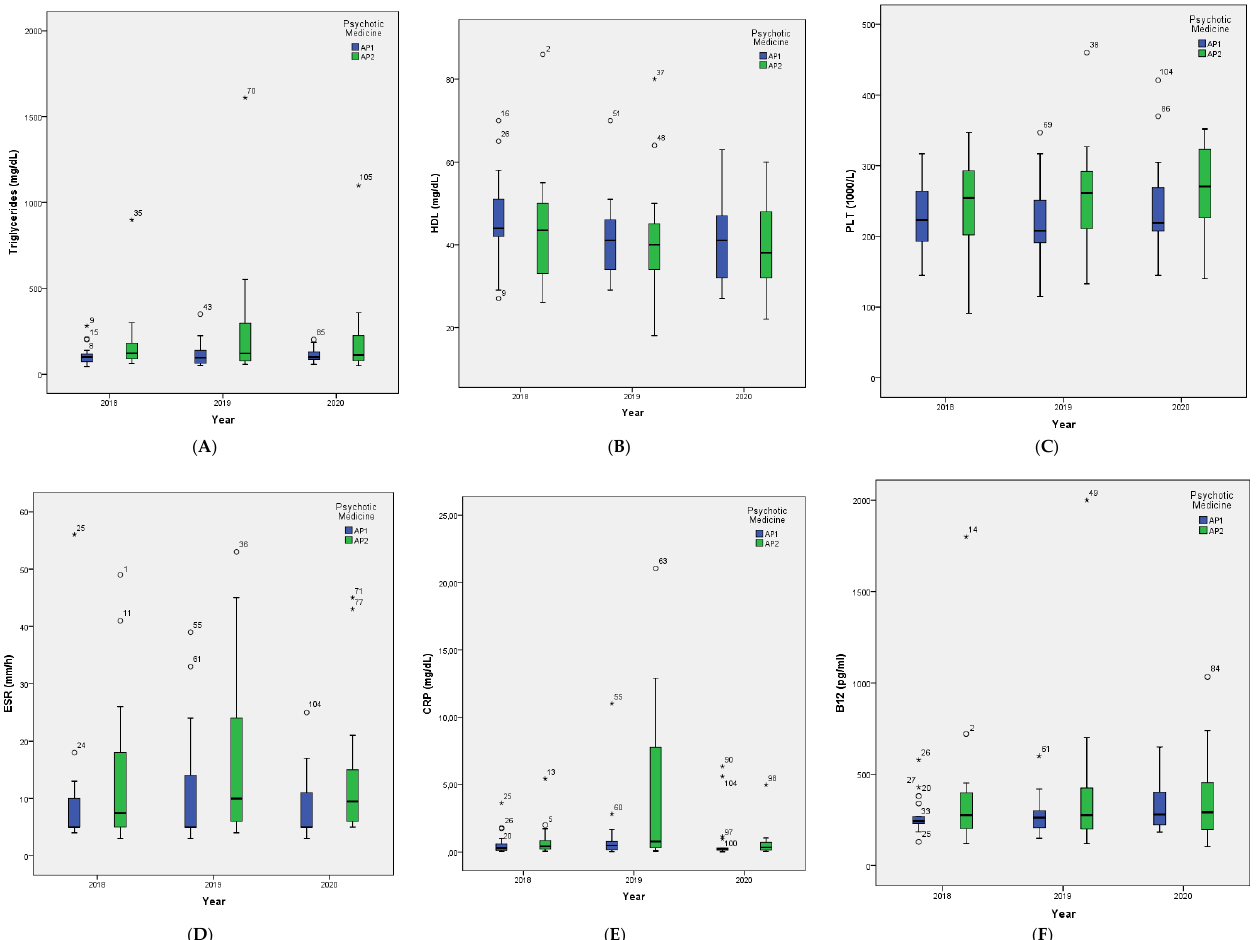
Figure 1. Box plots illustrating the changes of blood parameters in the subgroups of psychotic patients, depending on the antipsychotic medication (AP1, AP2), at the three yearly time points, 2018 (T1), 2019 (T2), and 2020 (T3). ( A ) triglycerides; ( B ) high density lipoprotein (HDL); ( C ) platelet count (PLT); ( D ) erythrocyte sedimentation rate (ESR); ( E ) C-reactive protein (CRP); ( F ) vitamin B12. AP1, antipsychotics related to a low to moderate risk of WG, namely aripiprazole, amisulpride, quetiapine, risperidone, and ziprasidone; AP2, antipsychotics related to a higher risk of WG, namely paliperidone, olanzapine, asenapine,